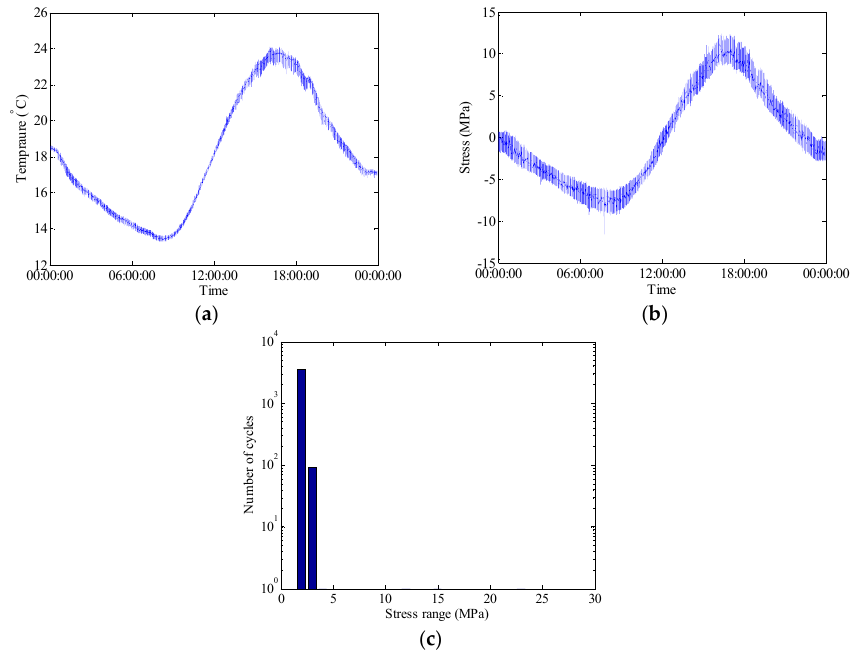
Figure 6. Raw data of selected FBG sensors during bridge construction phase on 17 October 2015: ( a ) Temperature time history measured by FBG-MS-NT-2; ( b ) Stress time history measured by FBG-MS-NS-2-3; ( c ) Histogram of daily stress spectrum.